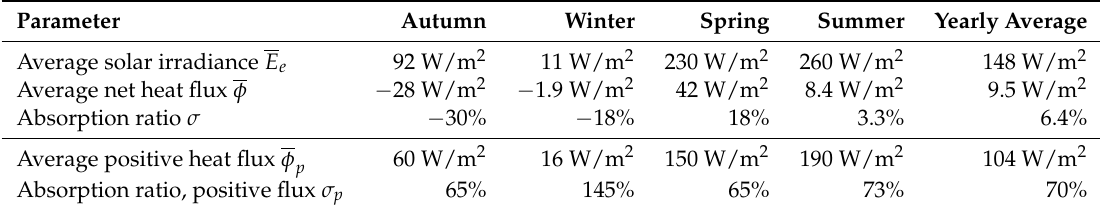
Table 3. Average solar irradiance, heat flux, and absorption ratios over five day periods in all seasons. The first three rows represent the average net heat collection values over the whole period and the next two rows represent the corresponding values for positive values. Parameter Autumn Winter